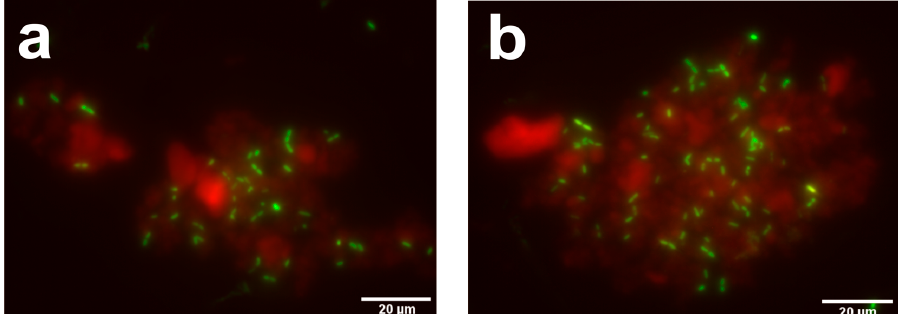
Figure 9. Representative z-stack projection images acquired by fluorescence microscopy showing E. (in green) (LL-37 concentration 400 µ g / mL) attached on LL-37-loaded CaP S agglomerates (in red) after coli (in green) (LL-37 concentration 400 μ g/mL) attached on LL-37-loaded CaP S agglomerates (in red) 2 h incubation time at 37 ◦ after 2 h incubation time at 37 °C.